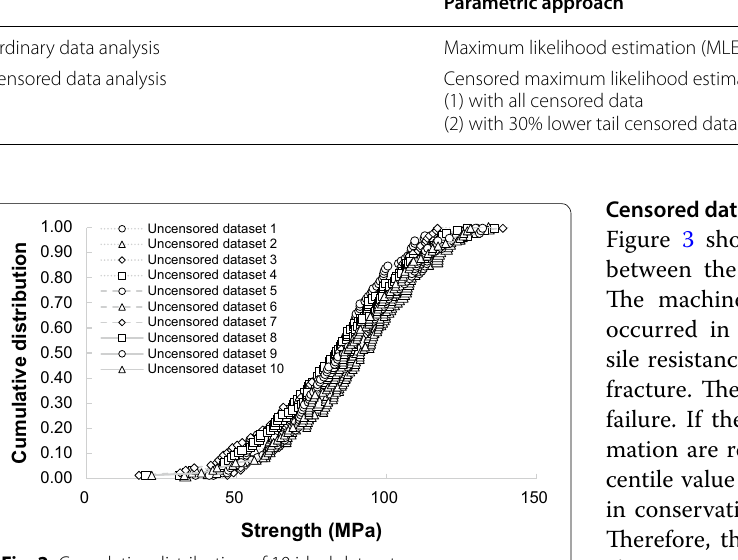
Fig. 2 Cumulative distribution of 10 ideal